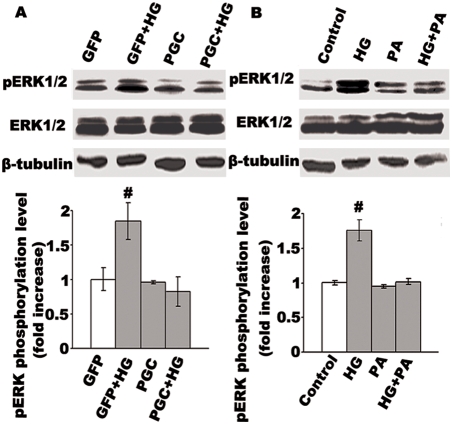
Increase of PGC-1α either exogenously by adenovirus or endogenously by palmitic acid abolished high glucose induced phosphorylation of ERK1/2 in VSMCs.VSMCs were infected with adenovirus for 24 h, then made quiescent by serum-starvation for 6 h, and then stimulated with HG for 4 h. Total protein were harvested and used to detect ERK1/2 activity (A). Cultured VSMCs in 5.5 mM glucose were made quiescent by serum-starvation for 6 h, then cells were either left untreated or stimulated with 15 mM glucose (HG) in the absence and presence of 0.4 mM palmitic acid (PA) for 12 h. ERK activity were determined by Western blotting with ERK1/2 (pT202/pY204) Phospho-Specific antibodies compared with b-tubulin antibody and densitometric analysis of ERK1/2 activity are showed. Representative blots of three similar results are showed. #P<0.001 compared with control.